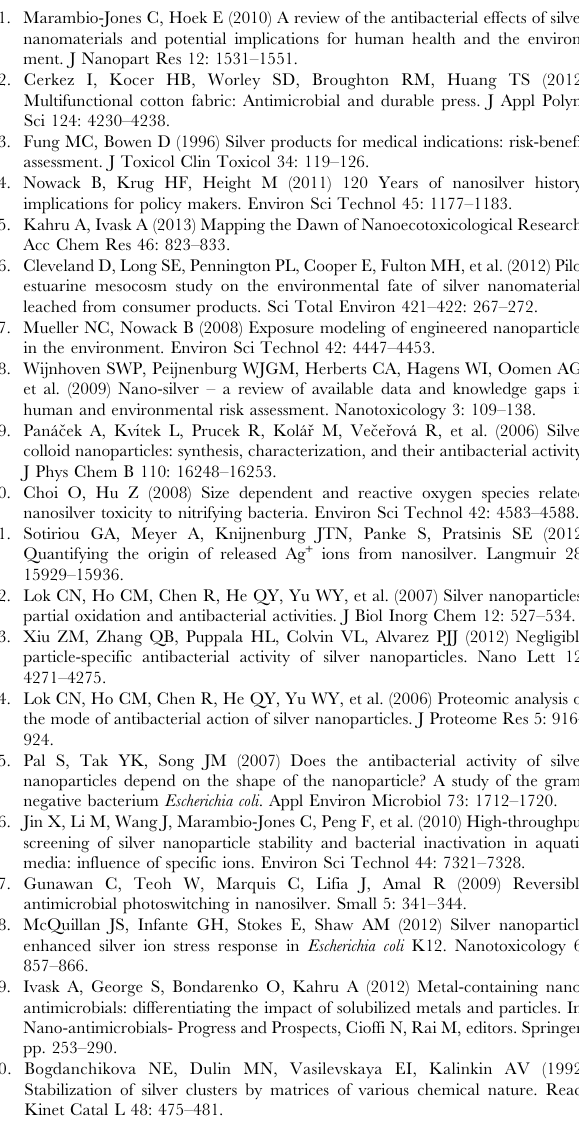
Table S3 f -potential of bacterial cells in half-strength NaCl-free LB